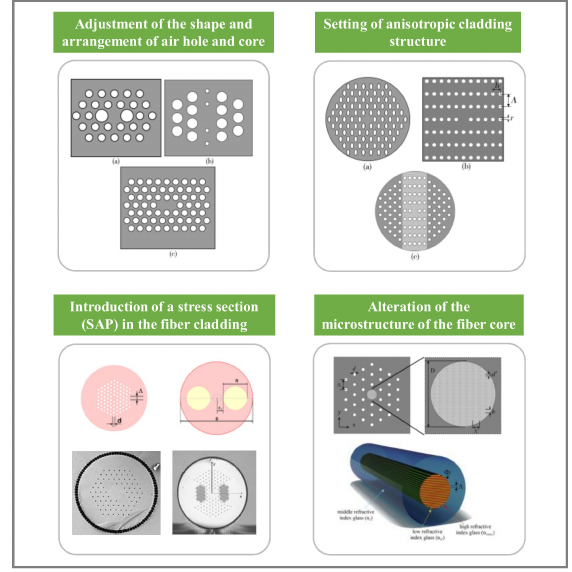
Figure 10. Technical route to achieve LMA-PCFs with high birefringence value